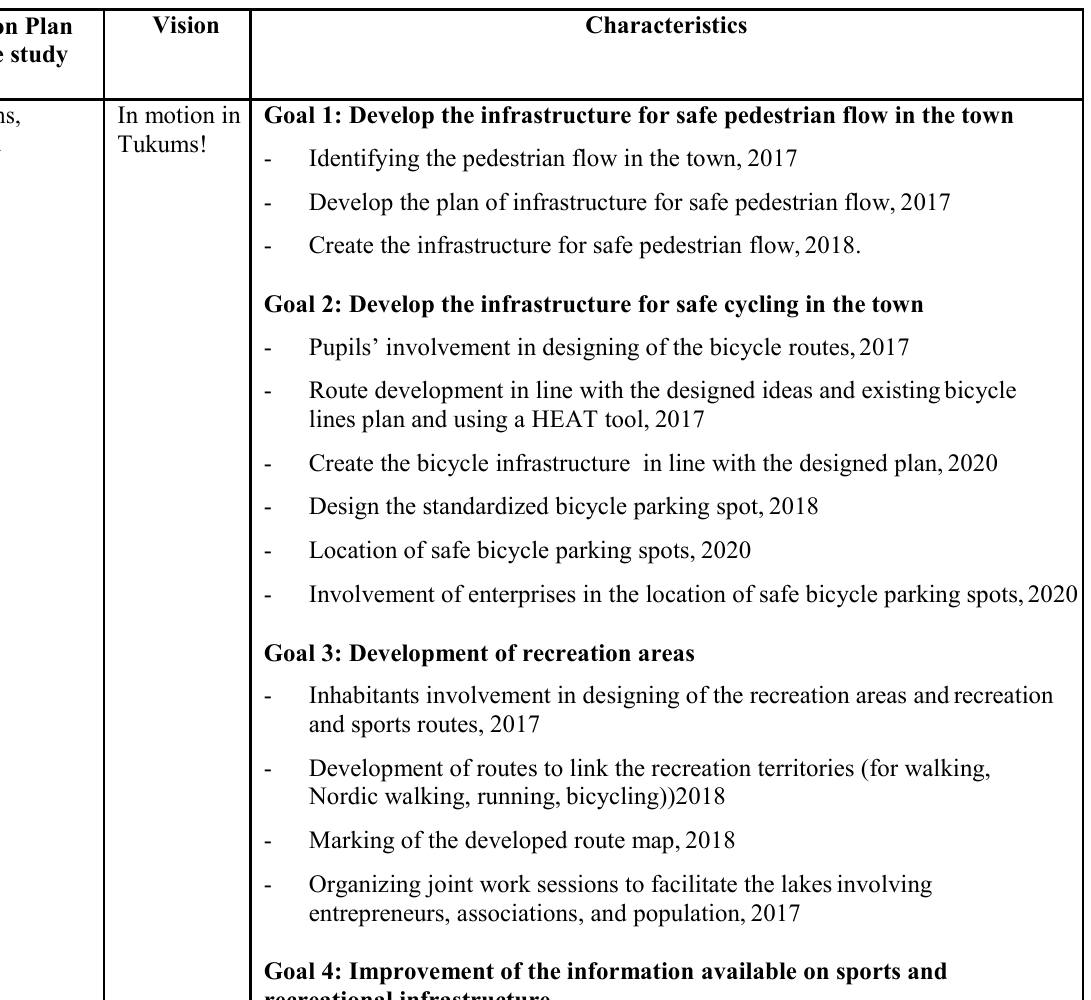
Table 1 – Summary of the UActivE Action Plan realized in Tukums,